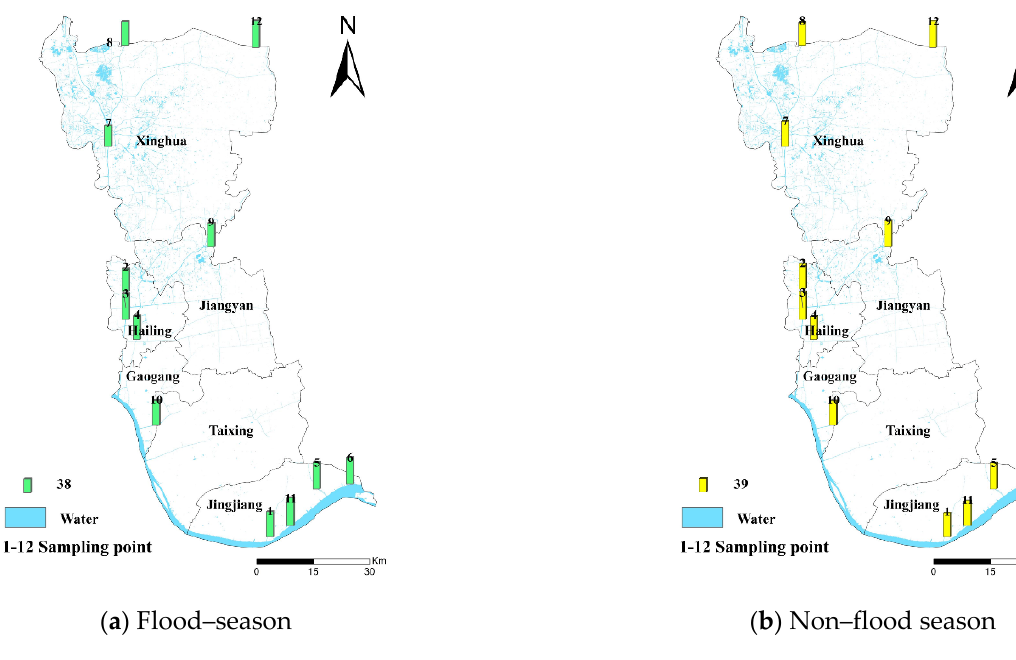
Figure 4. Spatial distribution of WQI evaluation results.